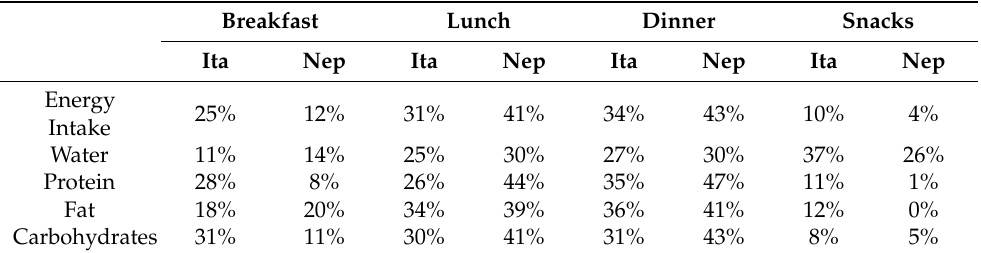
Table 1. Distribution of energy, water and macronutrients intake (%) among the principal meals and snacks in Italian (Ita) and Nepalese (Nep) group, averaged from food consumption diaries of